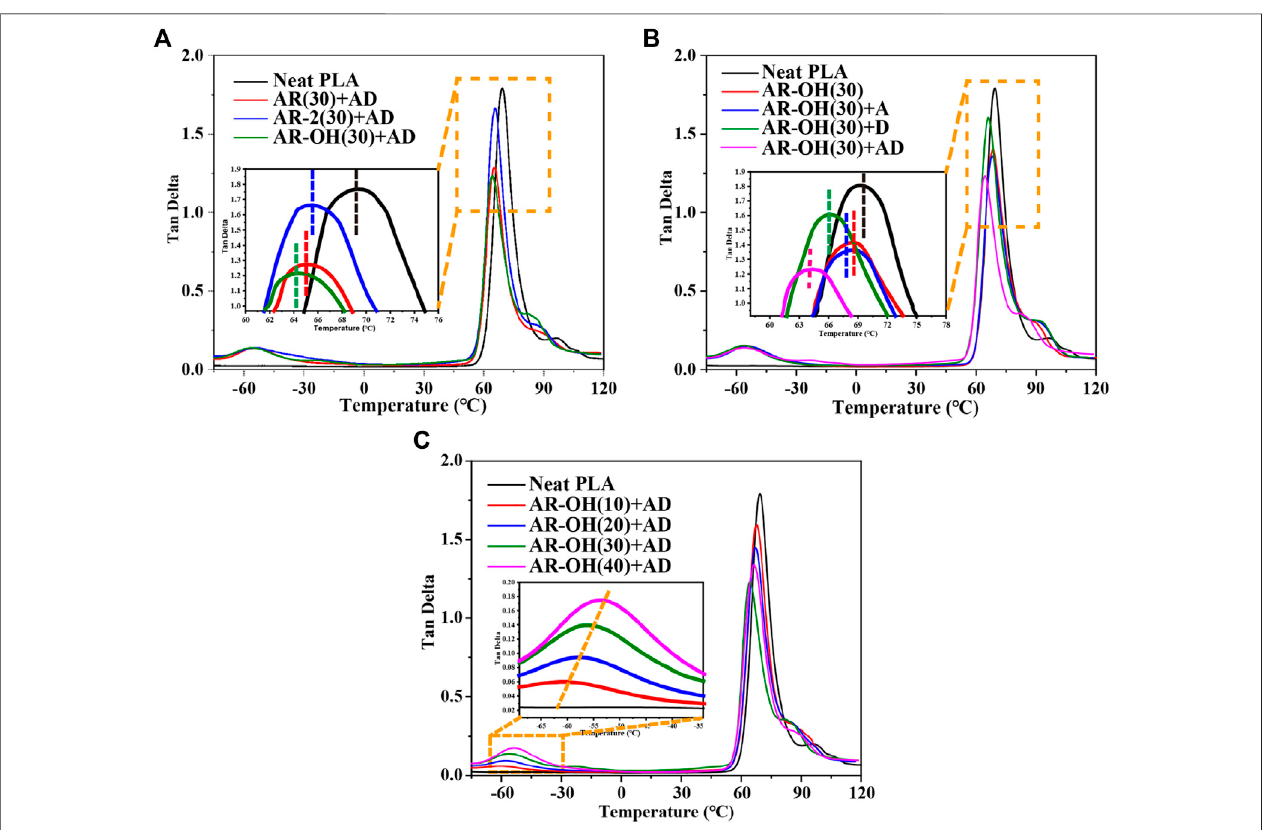
FIGURE 2 | Tan δ curves of the PLA/ i -BIIRs blends obtained by DMA: (A) neat PLA and PLA/ i -BIIRs blends with ADR and DCP added and 30 wt% content of ionomer, (B) neat PLA and PLA/ i -BIIR-OH blends with different addition of ADR and DCP, (C) neat PLA and PLA/ i -BIIR-OH blends with different ionomer content.